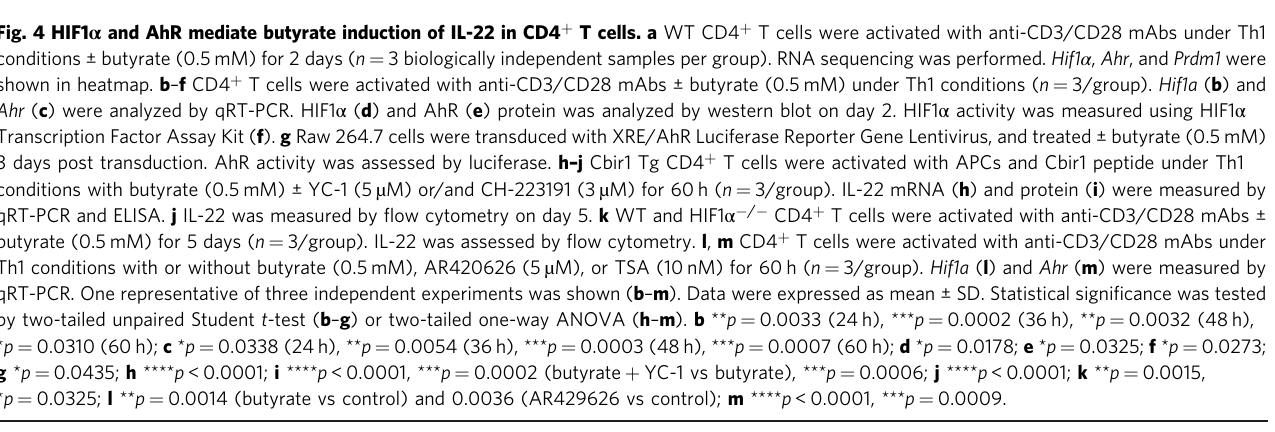
Fig. 4 HIF1 α and AhR mediate butyrate induction of IL-22 in CD4 + T cells. a WT CD4 + T cells were activated with anti-CD3/CD28 mAbs under Th1 conditions ± butyrate (0.5 mM) for 2 days ( n = 3 biologically independent samples per group). RNA sequencing was performed. Hif1 α , Ahr , and Prdm1 were shown in heatmap. b – f CD4 + T cells were activated with anti-CD3/CD28 mAbs ± butyrate (0.5 mM) under Th1 conditions ( n = 3/group). Hif1a ( b )